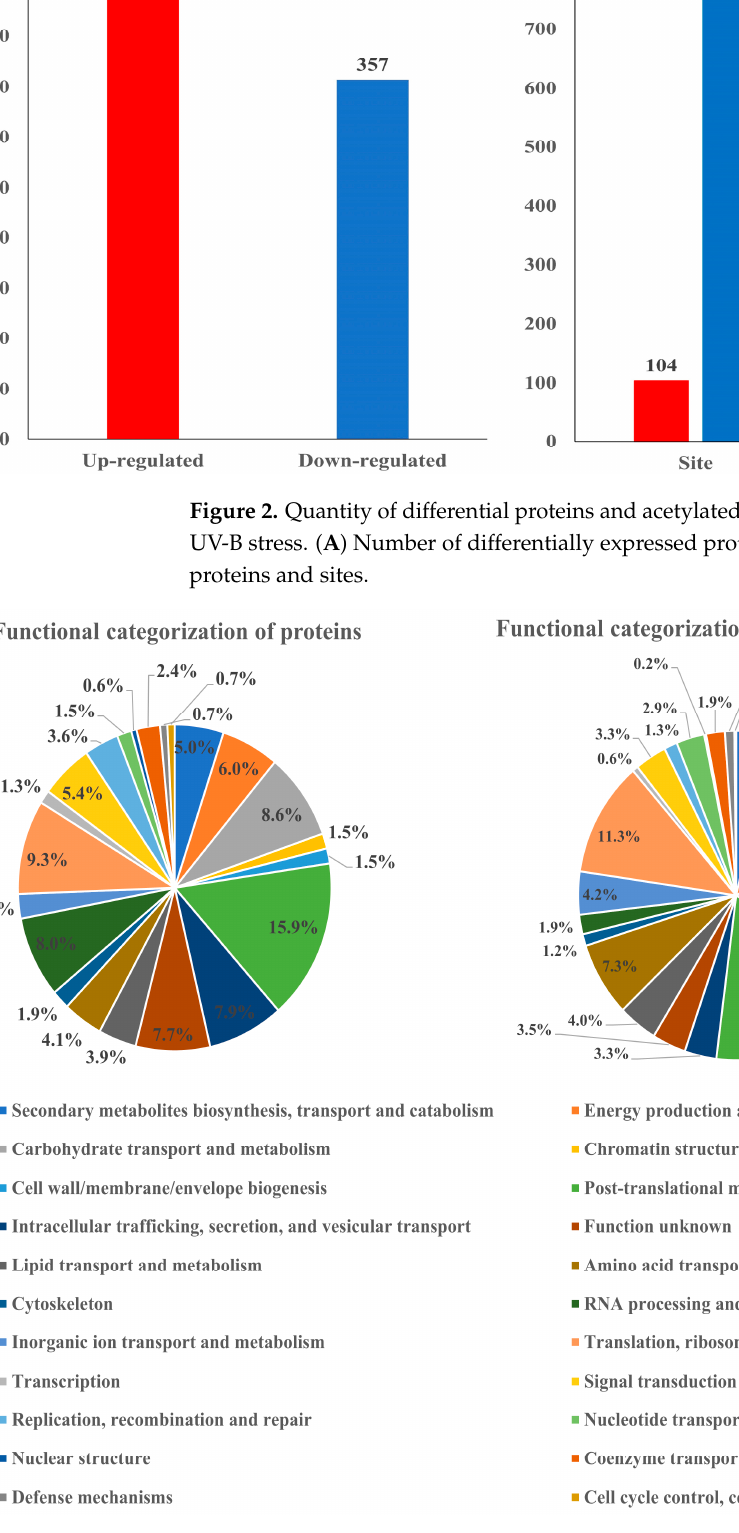
Figure 3. COG classification of differential proteins and differential acetylated proteins under UV-B